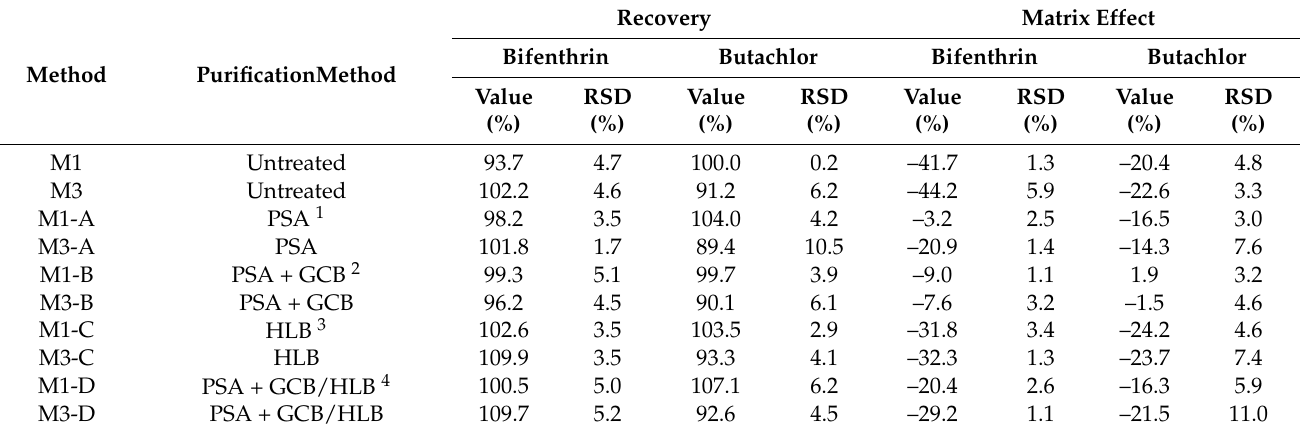
Table 3. Recovery rate and RSD analyzed after preparation using various purification